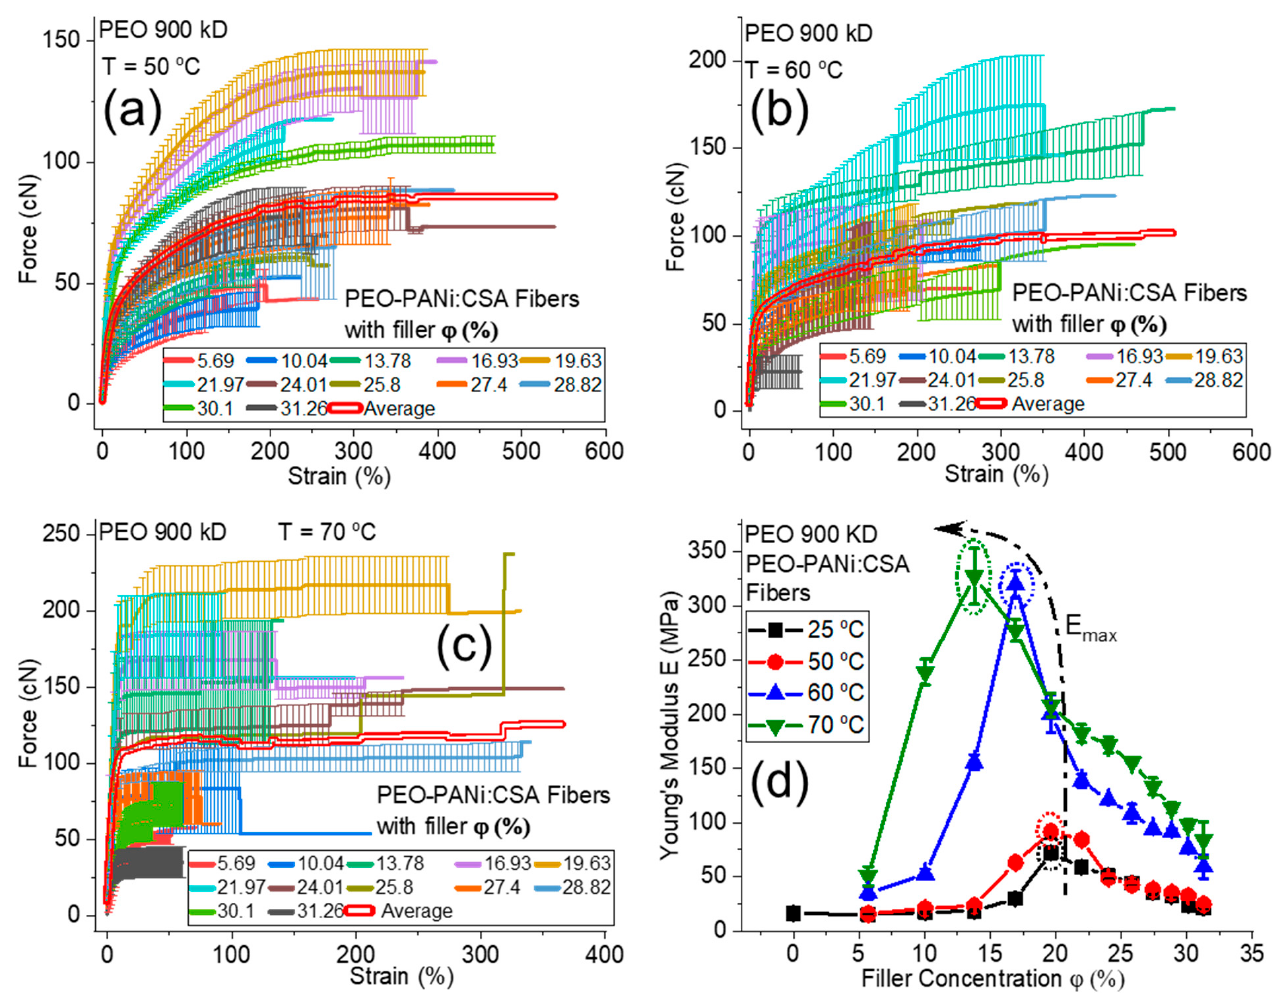
Figure 8. Panels ( a – c ) show the force-strain curves for PEO (900 kD)-PANi:CSA fibers using 50, 60, and 70 ◦ C annealing temperatures, respectively. The percentage volume fraction ( ϕ % ) of PANi varies from 0–31%. The bold double red lines ( a – c ) represent the average of all force-strain curves. Panel ( d ) shows elastic Young’s modulus ( E ) as a function of percentage volume fraction ( ϕ % ) of PANi for PEO(900 kD)-PANi:CSA fibers at 25 (un-annealed), 50, 60, and 70 ◦ C annealing temperature. The dotted circles ( d ) represent the maximum elastic Young’s modulus ( E max ) for each annealing temperature.